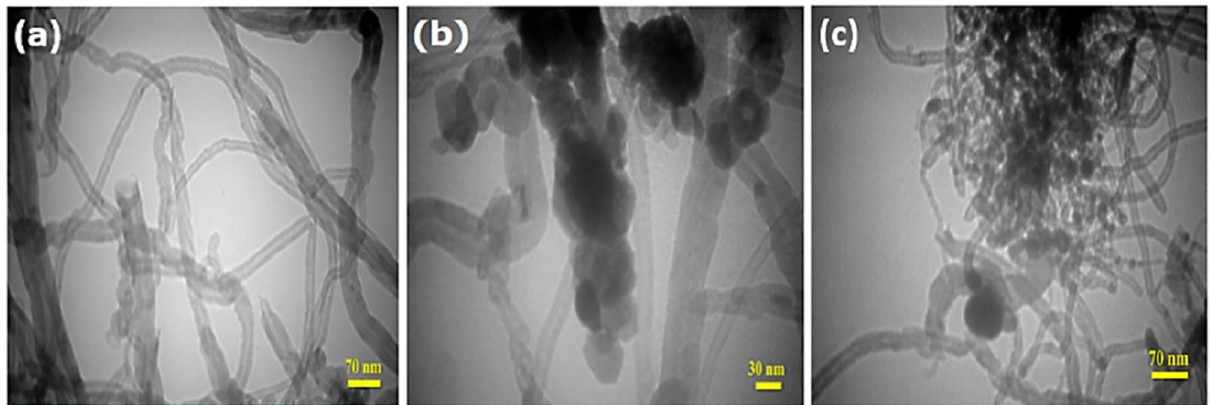
Figure 4. TEM images of ( a ) the f -SWCNTs, ( b ) ZnO–Ag-SWCNTs, and ( c )